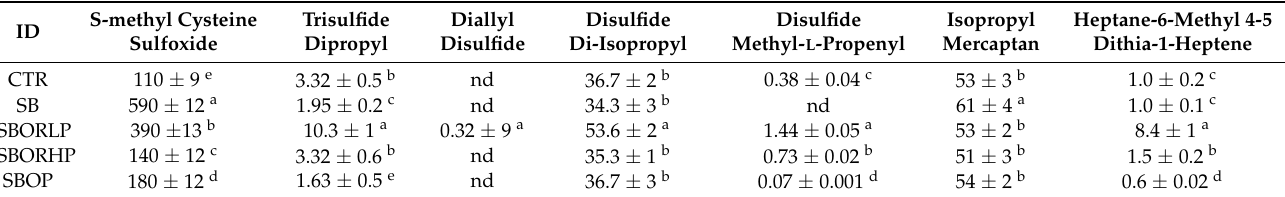
Table 2. S-Methyl- L -cysteine sulfoxide ( µ g · g − 1 FW) and the relative concentration µ g · g − 1 FW of volatile organic compounds in the onion bulbs differently fertilized: control (CTR), sulphur bentonite (SB), sulphur bentonite-low percentage orange residue (SBOR LP), sulphur bentonite-high percentage orange residue (SBOR HP), and sulphur bentonite-olive pomace (SBOP). Data are the mean of three replicates ± the standard error.